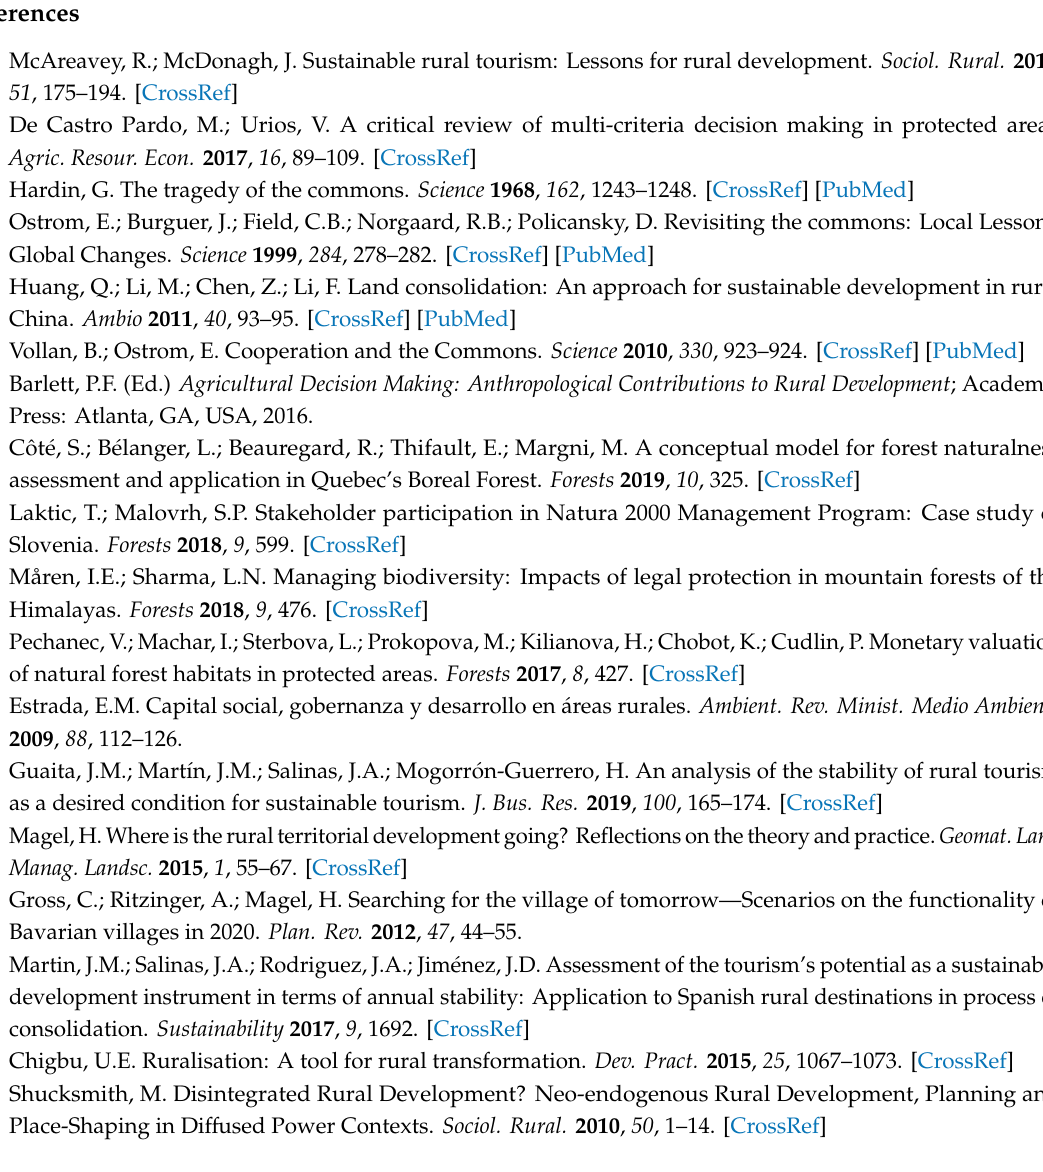
Table S1: Example of questionnaire for “Estudio sobre la ordenaci ó n integrada de los Parques Naturales de la Reserva de la Biosfera Transfronteriza Meseta Ib é rica”. This is an English translation to of the original questionnaire in Spanish and